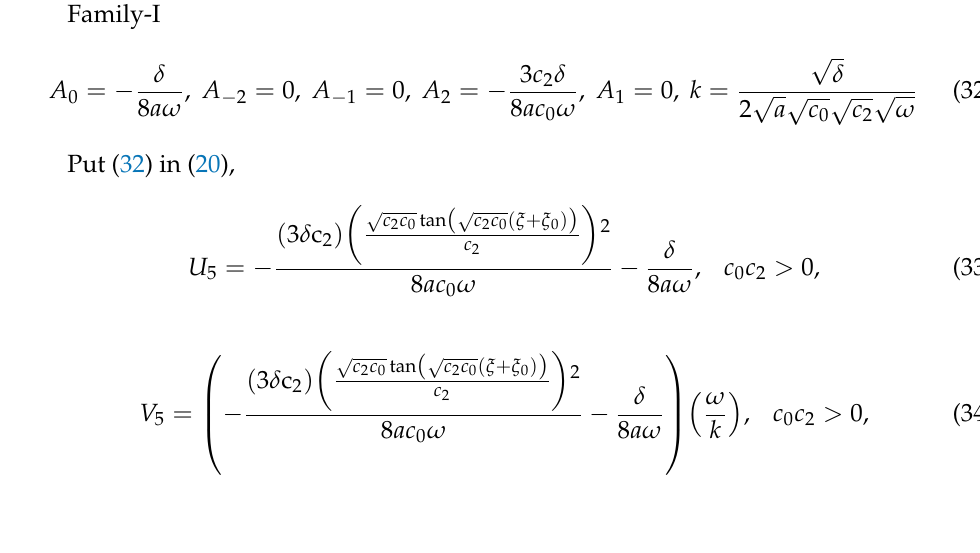
Figure 1. The profile of solutions U 2 ( a , b ) and V 2 ( c , d ) with α = 1, c 0 = 2, c 2 = 1, c 1 = 2, k = − 0.2, a = 2.01, ω = 0.5, ξ 0 = 10.5 and α = 1, c 0 = 2, c 2 = 1, c 1 = 2, k = 0.4, a = 2.01, ω = 1.05, ξ 0 = 0.5